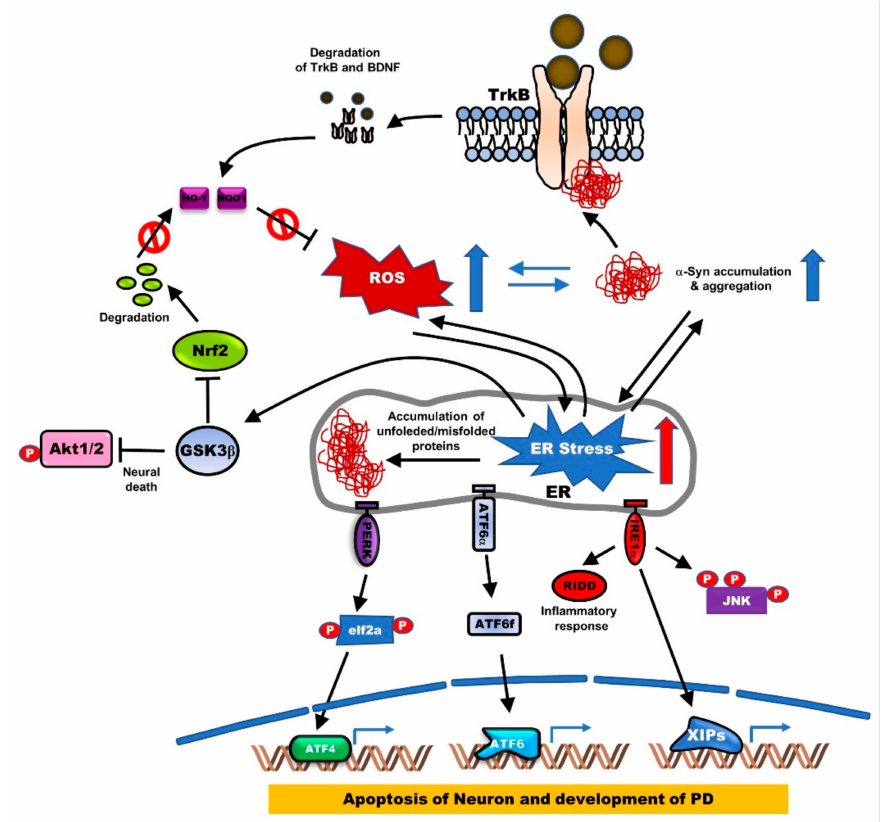
Figure 3. The generation of endoplasmic reticulum (ER) stress by ROS and accumulation of α -syn aggregates disrupts BDNF-TrkB-mediated neuronal protection. Accumulation or mutation of α -syn in PD reduces BDNF or TrkB expression through TrkB ubiquitination, and its reduction of BDNF-TrkB signaling leads to the generation of ER stress by induction of ROS or accumulation of α -syn. ER stress triggers the misfolding of proteins, leading to the accumulation of protein aggregates. Accumulation of protein aggregates activates protein kinase RNA-like ER kinase (PERK), activating transcription factor (ATF6 α ), and inositol-requiring protein (IRE1 α ) as three main transmembrane proteins in the ER. The activation of PERK, which induces eukaryotic Initiation Factor 2 α (eIF2 α ) phosphorylation, inhibits protein translation and increases ATF4, which is involved in apoptosis through induction of the CCAAT-enhancer-binding protein (C / EBP) homologous protein (CHOP) known as growth arrest and DNA damage-inducible protein. Also, activated IRE1 α induced neuronal apoptosis by induction of c-Jun N-terminal kinase (JNK) phosphorylation, or by increasing inflammatory response inducting IRE1 α -dependent messenger RNA decay (RIDD). Additionally, the production of ATF6 fragment (ATF6f) by cleavage of ATF6 in the Golgi apparatus is involved in the development of PD by inducing apoptosis of neuronal